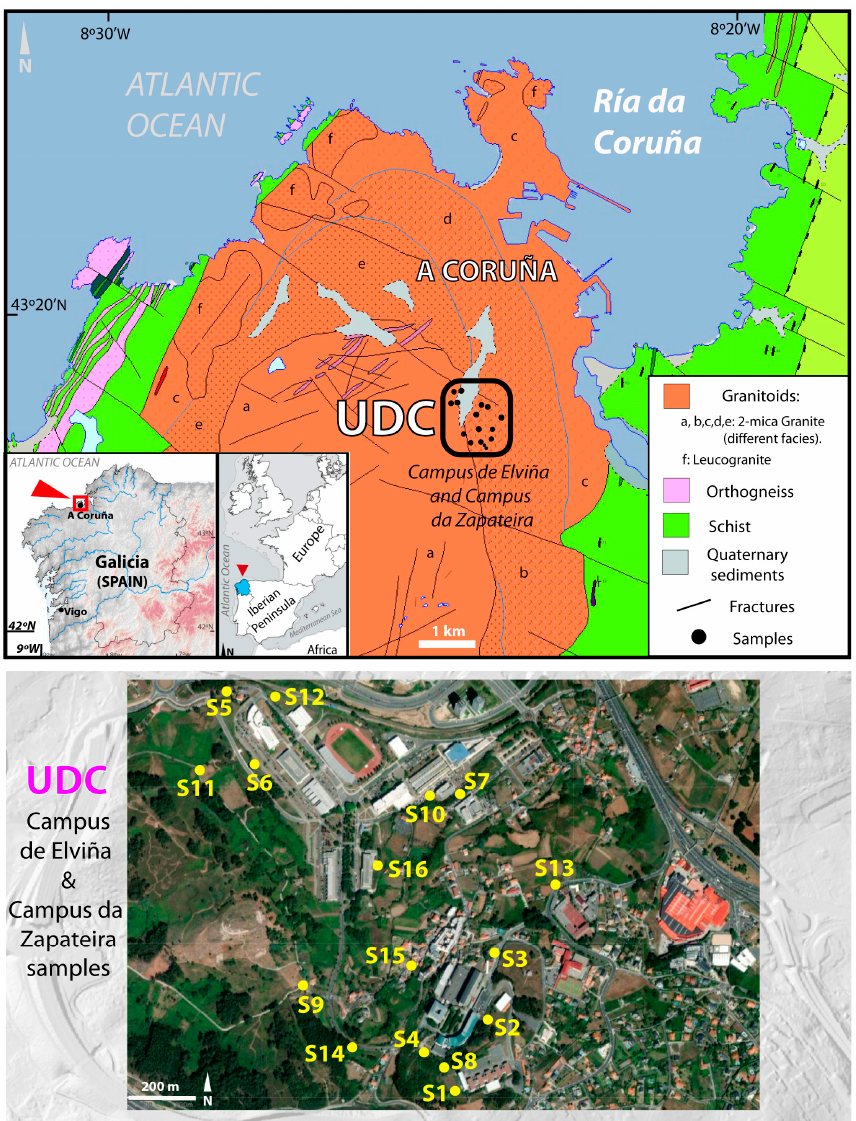
Figure 1. Location of the Elviña-A Zapateira campus of the University of A Coruña (northwest Spain), with a geological map of the study area (modified from [33]). Satellite image from Google Earth. Sampling sites are marked and explained in Table 1.